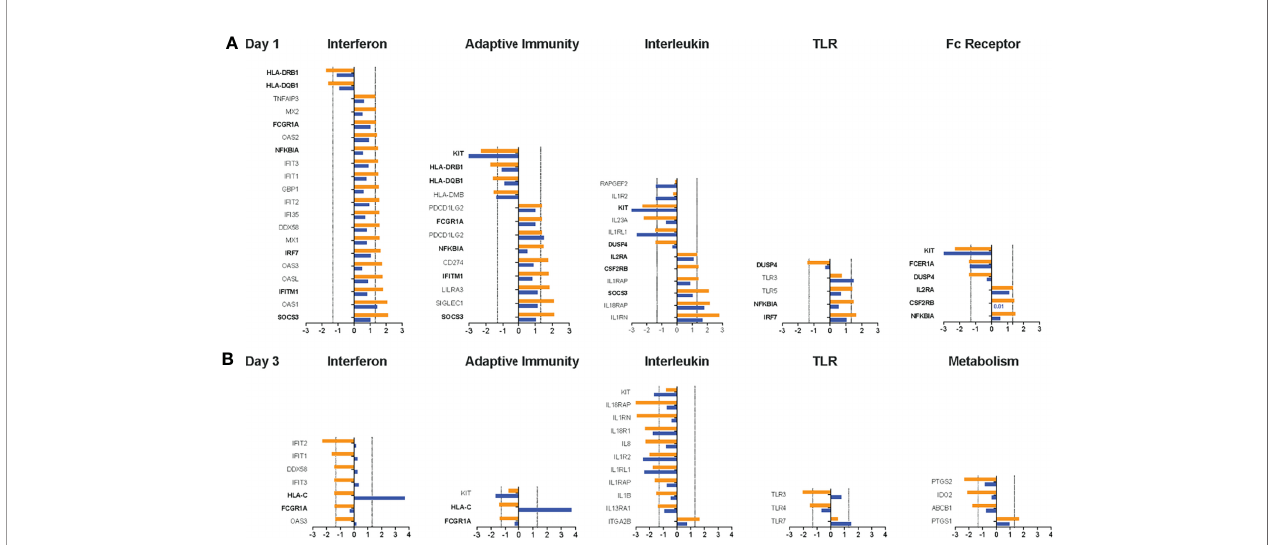
vs . D0 ( Figure 7B ) in Group 1 to the mRNA expression of the same genes in Group 2 without considering whether the raw or adjusted p value was <0.05 ( Supplementary Table S4 ). We selected the fi ve pathways with the highest increase or decrease in pathway score on D1 or D3 compared to D0. Consistent with the fi nding that several of the DEG were part of the interferon